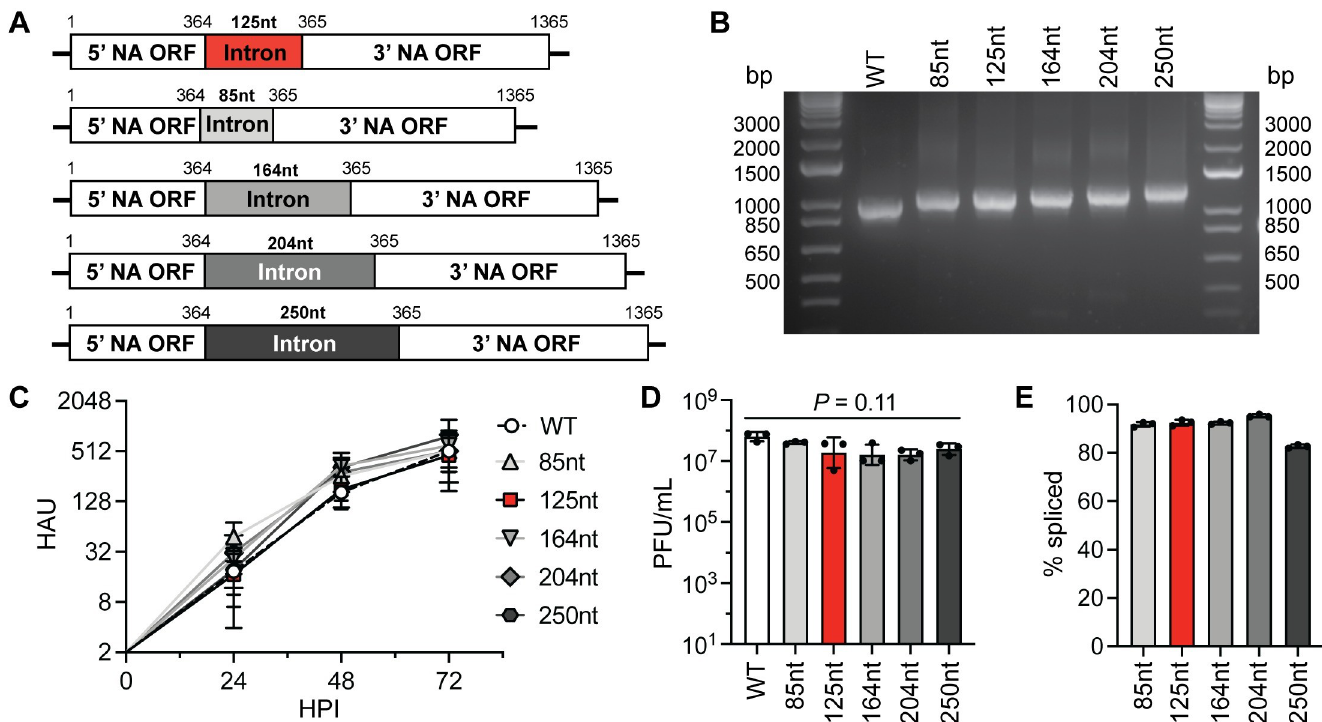
Fig 2. Intronic length has minor effects on viral fitness. (A) Diagrams of PR8 IAV segment 6/NA with artificial introns of varying lengths (gray) compared to the initial sequence (red). (B) RT-PCR for segment 6/NA of WT PR8 virus and PR8-NA-intron (varying lengths) viruses. (C) Growth kinetics of WT PR8 and PR8-NA- intron (varying lengths) virus infections (MOI = 0.001, multicycle) on MDCK cells, measured using HA assays (mean with SD, n = 3 independent experiments). (D) End point titers of WT PR8 and PR8-NA-intron (varying lengths) virus infections (MOI = 0.01, multicycle, 72h) on MDCK cells, measured using plaque assays (mean with SD, n = 3 independent experiments, one-way ANOVA). (E) PR8 segment 6/NA-intron mRNA splicing rates from PR8-NA-intron (varying lengths) virus infections (MOI = 2, single cycle, 8h) on MDCK cells, measured using two-step RT-qPCR (mean with SD, n = 3 independent experiments).